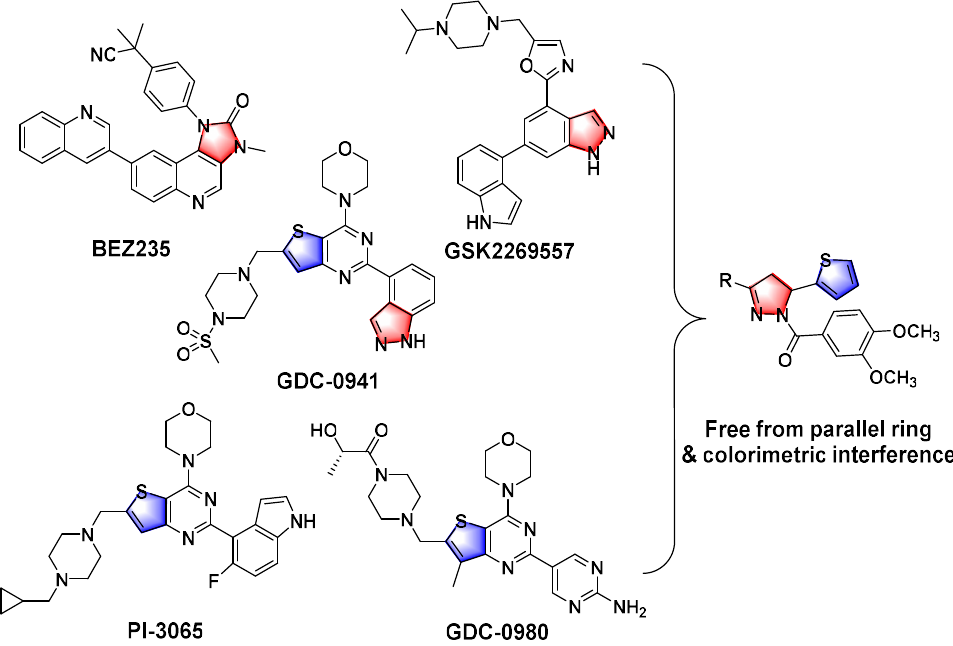
Figure 1. The design concept of this work, introducing the reported functional groups and simpli- fying the parallel ring structures. the parallel ring